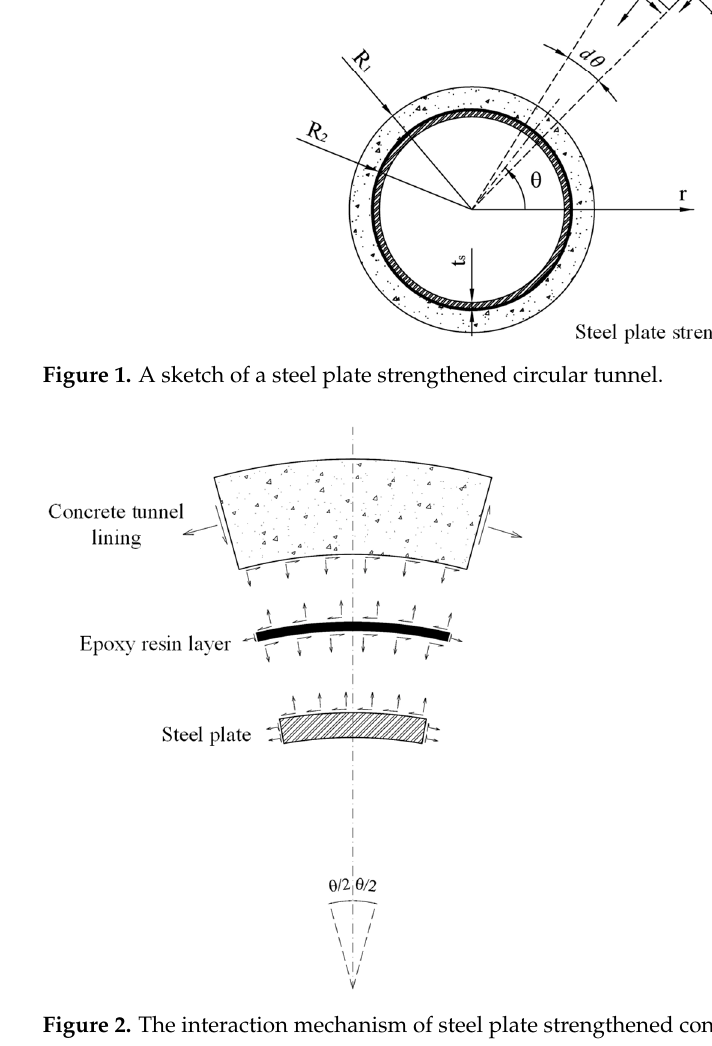
Figure 2. The interaction mechanism of steel plate strengthened concrete tunnel lining.